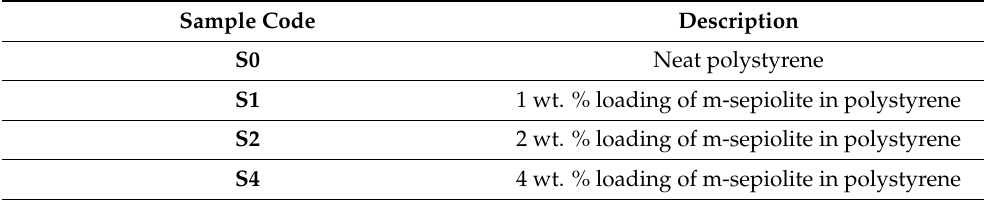
Table 1. Sample codes and designation of pristine polymer and polymer nanocomposite.